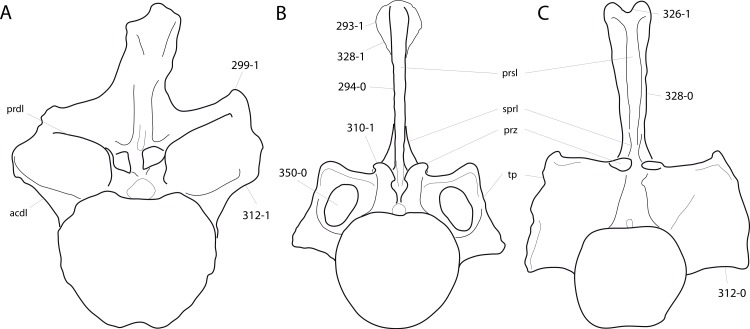
Diplodocimorph anterior caudal vertebrae.Anterior caudal vertebrae of Demandasaurus darwini MDS-RVII,610 (A; traced from Torcida Fernández-Baldor et al., 2011), Brontosaurus excelsus YPM 1980 (B; traced from Ostrom & McIntosh, 1966), and Diplodocus carnegii CM 84 (C; traced from Hatcher, 1901) in anterior view. Note the lateral triangular processes (B; C293-1), the mostly rectangular outline of the spine (B; C294-0), the wing-like transverse processes (A; C299-1), the convex prezygapophyses (B; C310-1), the laterally (C; C312-0) or dorsally directed ventral surface of the transverse process (A; C312-1), the notched neural spine top (C; C326-1), the gradual (C; C328-0) or abrupt distal expansion of the spine (B; C328-1), and the foramen piercing the transverse process (B; C350-0). Abb.: prsl, prespinal lamina; prz, prezygapophysis; sprl, spinoprezygapophyseal lamina; tp, transverse process. Scaled to same total height.